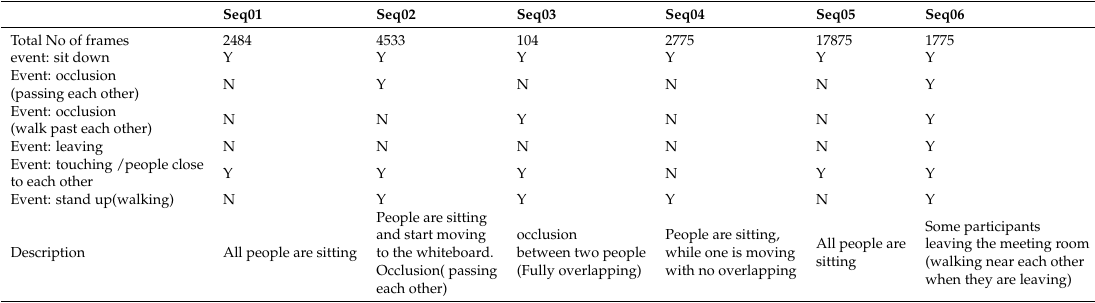
Figure 4. Example from ES2002a video. Frame 1700 shows the meeting room when participants are sitting around the table. Frame 7009 is an example of the challenge when people are passing each other. Frames 7034 and 8679 show touching cases. Examples of occlusion (overlapping) are shown in frames 8714 and 8716. Table 1. Challenges in the ES2002a video. In these 6 sequences, we identify the presence (Y) or absence (N) of specific